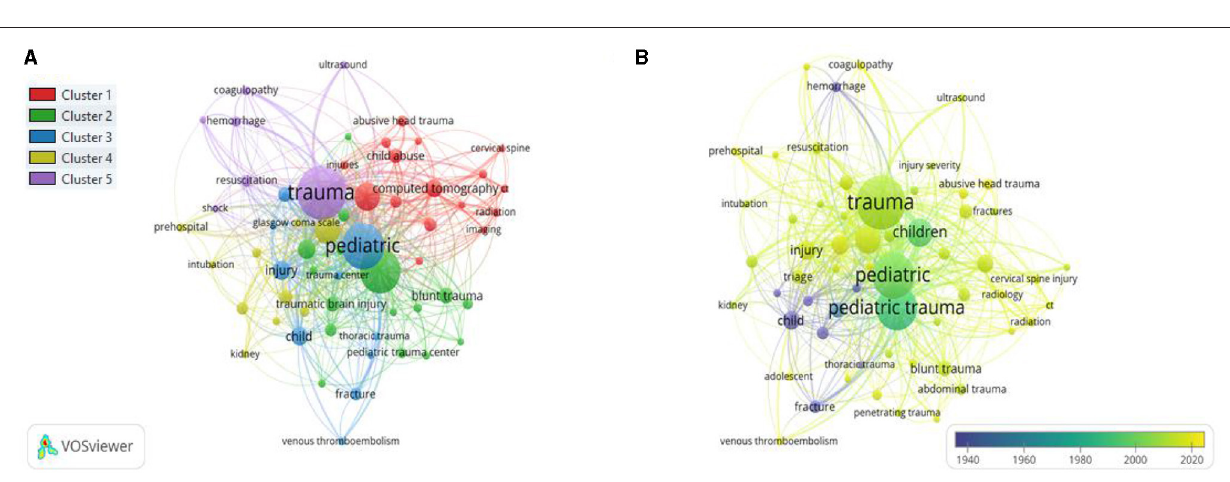
and hospitals publishing the high cited publications and